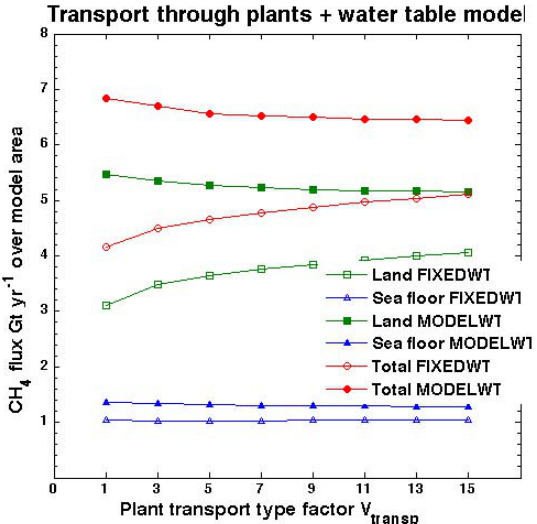
Fig. 2. Increasing the oxidation parameter ( f ox ) values results in a strong decrease of the CH 4 emissions for the model domain. The decrease is linearly related to f ox .